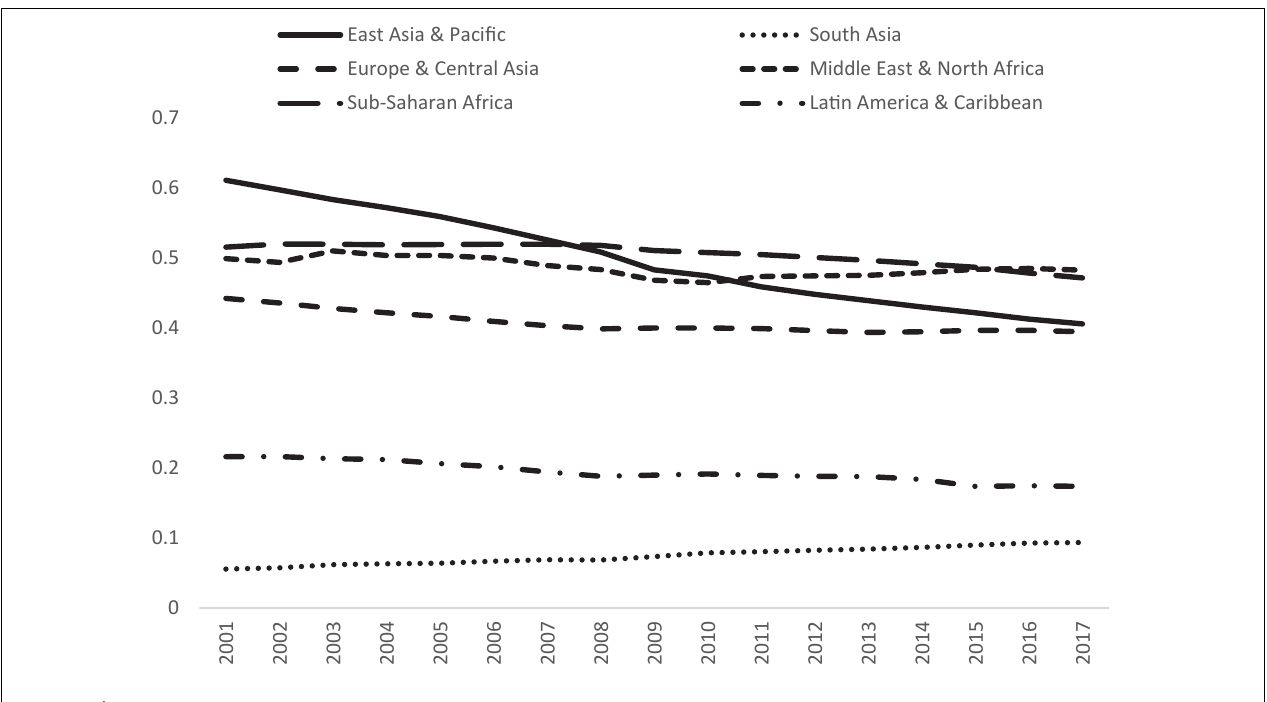
FIGURE 7 | Gini coefficients for different regions, 2001 to 2017. Source: Authors’